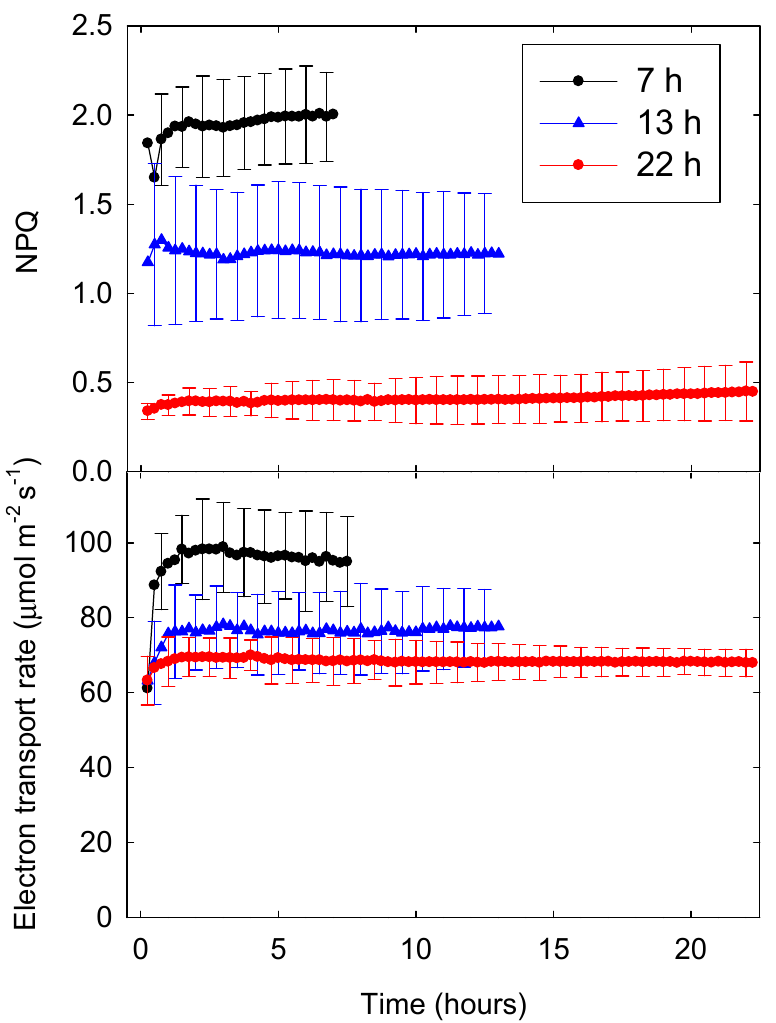
Figure 2. Non-photochemical quenching (NPQ, top) and electron transport rate (ETR, bottom) of lettuce ( Lactuca sativa ‘Green Towers’) under three different photoperiods (7, 13, and 22 h) with a daily light integral (DLI) of 20 mol m − 2 d − 1 over the course of the photoperiod. The area under each ETR curve represents the daily photochemical integral (DPI). Data are the means of three replications ± SD.